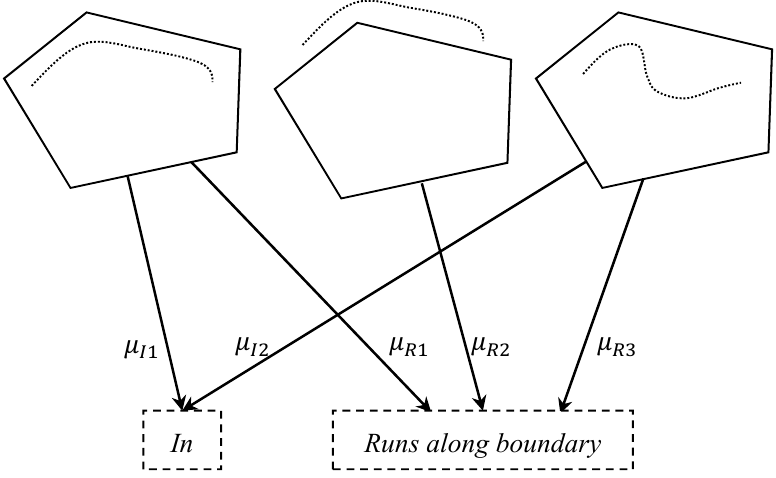
Figure 1. Examples of line-region sketches. µ I 1 and µ I 2 are degrees with which the sketches can be described by NLSR term In . µ R 1 , µ R 2 and µ R 3 are degrees with which the sketches can be described by NLSR term runs along boundary .